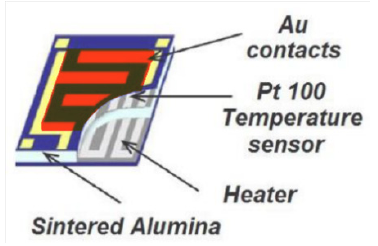
Figure 1. Top view of a sensor. The light blue central layer is the alumina substrate; the yellow lines are the gold contacts employed to connect the sensor to the external circuits; the grey coil at the bottom face of the substrate is the heater; the red area is the active material, distributed between the gold